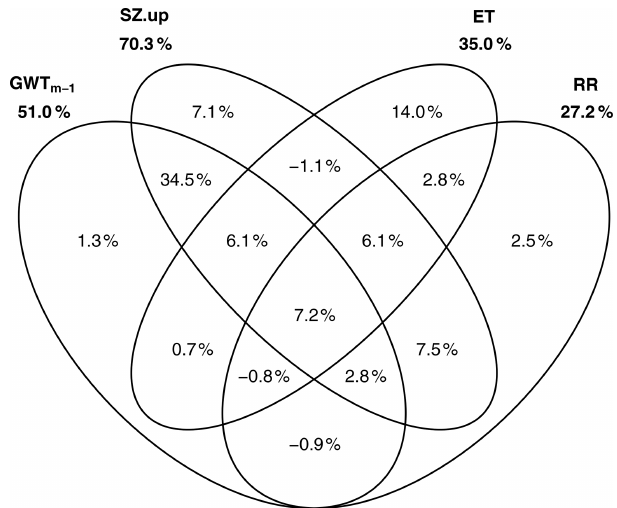
Figure 14. Venn diagram of the variation partitioning results. The diagram shows the proportion of deviance in groundwater table depth (GWT) explained independently or jointly by groundwater table depth in the preceding month (GWT m − 1 ), upward saturated flow from the lower computational layer (SZ.up), actual evapotran- spiration (ET) and/or precipitation (RR), based on simulated spa- tially averaged monthly means in the peat soil domain for the period